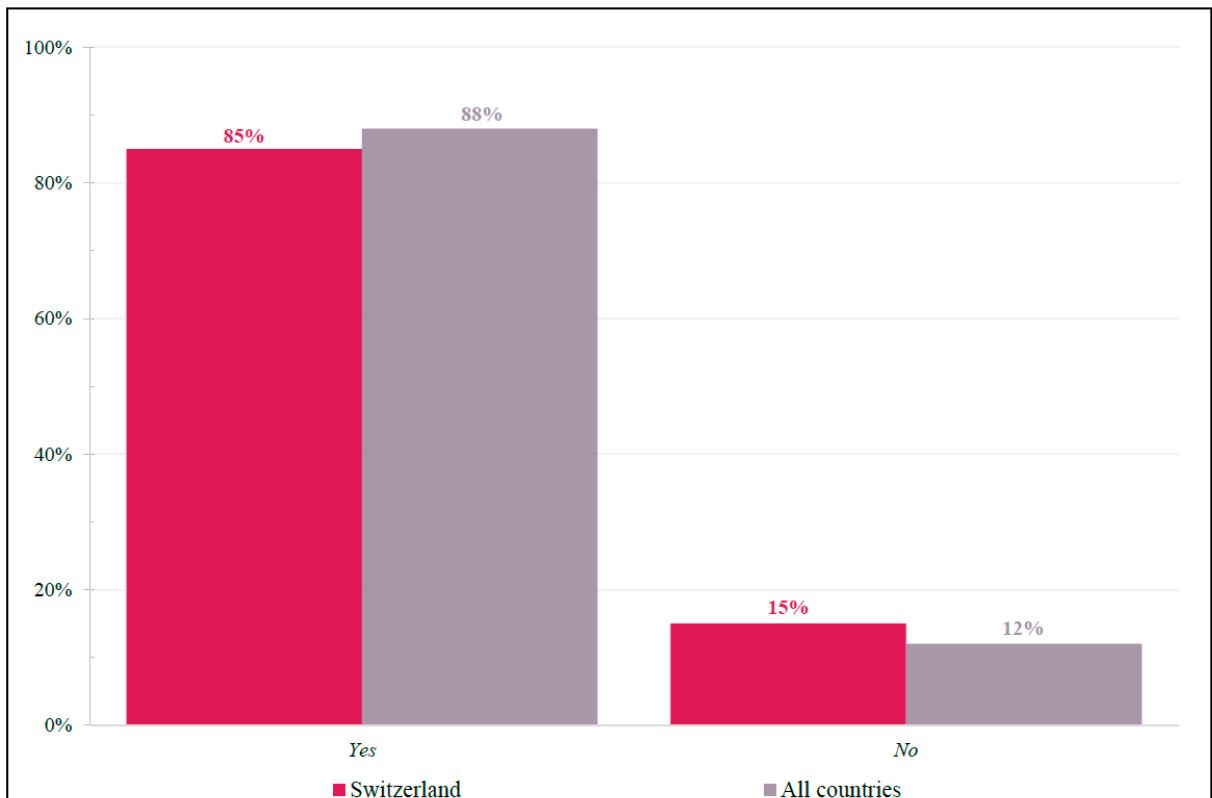
Figure 4. Case 1: Trifluridine-tipiracil Appropriateness. Yes/No response frequencies of physicians when asked whether they considered trifluridine-tipiracil as an appropriate 3L treatment choice for patient case #1. Shown as a percentage of